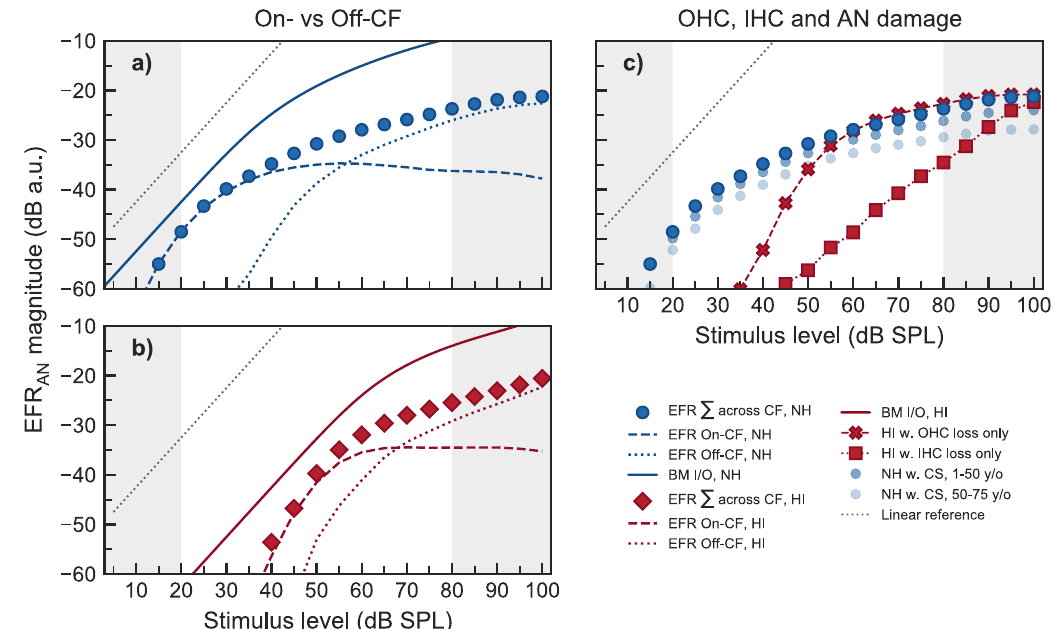
Figure 7. Analysis of on- vs off-CF contributions and OHC vs IHC dysfunction on the simulated EFR AN magnitude-level functions from the 4 kHz component. Panel ( a ) shows NH simulated EFR AN magnitude-level function after summing contributions across CF (circles), the contribution to EFR AN from neurons in the on-CF range (dashed line) and the contributions from off-CF neurons (dotted line). The solid line shows the growth of 2 the BM output. Panel ( b ) shows the same as panel a but assuming hearing impairment with a combinations of 3 1 EFR AN magnitude-level of OHC dysfunction and 3 of IHC dysfunction. Panel ( c ) shows the same simulated HI functions as in panel ( b ) (summed across CFs) but assigning the threshold elevation to only OHC dysfunction (red crosses, dashed line) or to only IHC dysfunction (red squares, dotted line). The NH simulation is shown by blue circles as a reference. The grey-dotted line in all panels indicate a linear